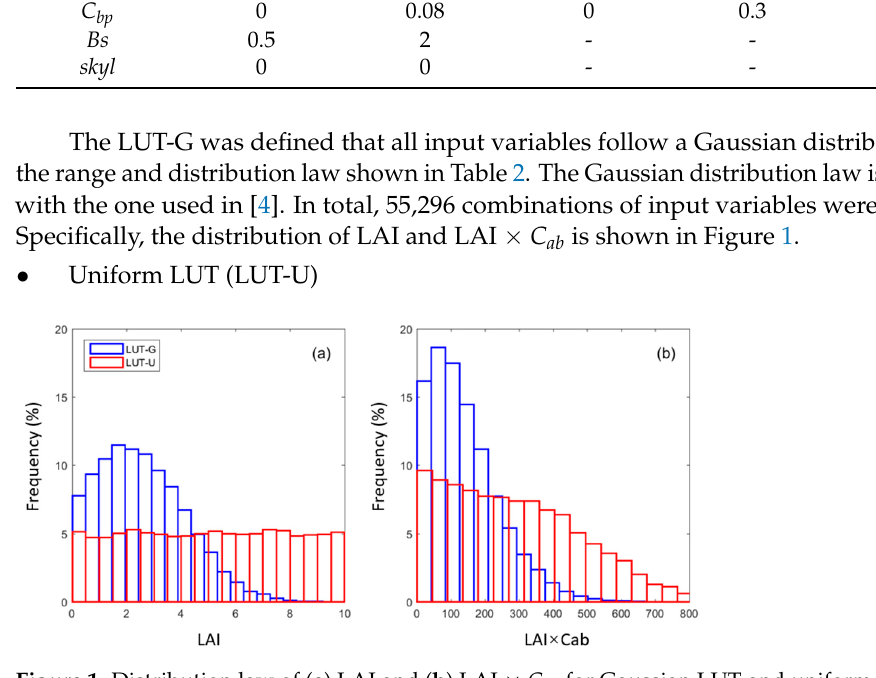
Figure 1. Distribution law of ( a ) LAI and ( b ) LAI× C ab for Gaussian LUT and uniform LUT.